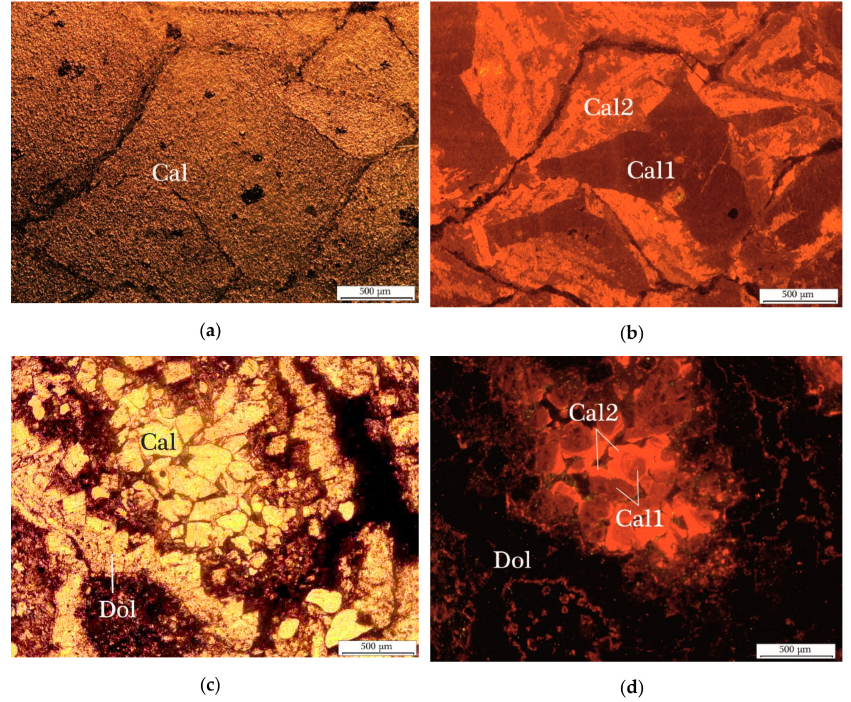
Figure5. Petrographyandcathodoluminescence(CL)characteristicsofthestudiedcarbonateanthraconites: ( a ) sample 6-1-2 (Syas River), cross-polarized light, ( b ) the same sample, in CL; ( c ) sample 4-6 (Popovka River), cross-polarized light, ( d ) the same sample, in CL; Cal1—the earliest calcite generation (dark red and red zonal in CL), Cal2—the second calcite generation, Cal—calcite,